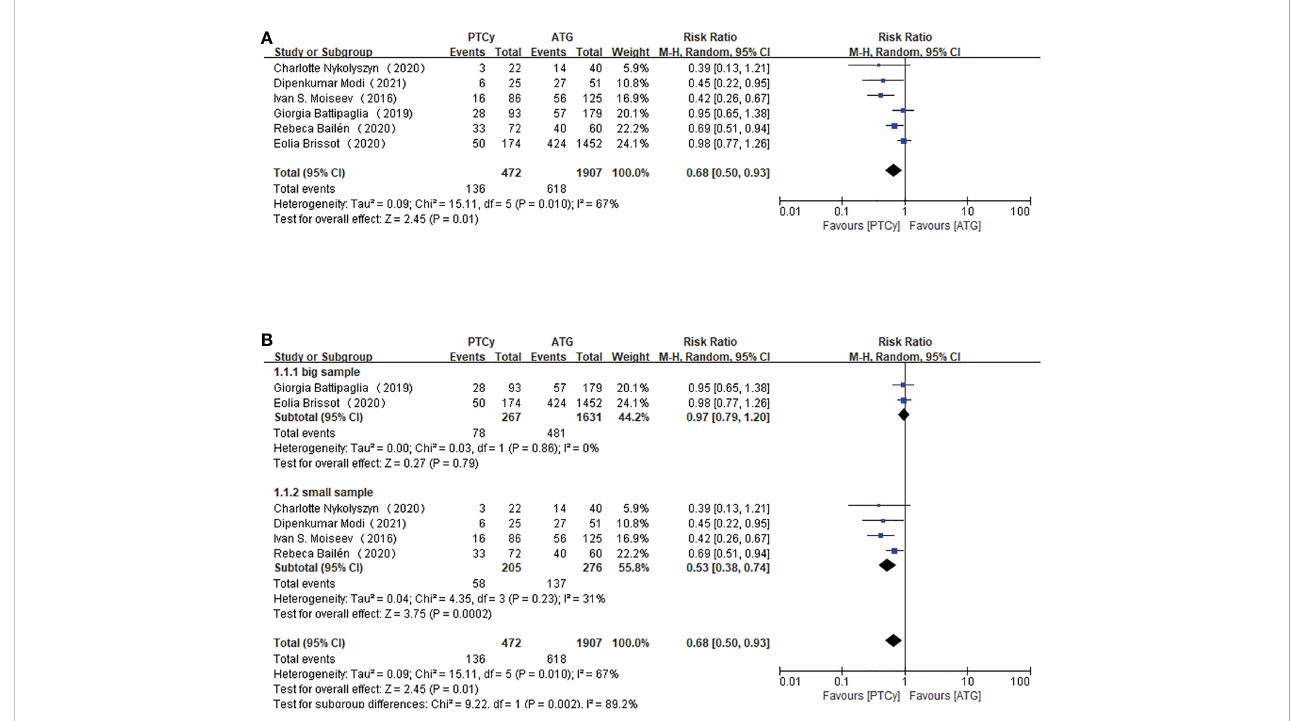
FIGURE 2 Forest plot of II-IV aGVHD (A) and Subgroup analysis of II-IV aGVHD according to the sample size (B)